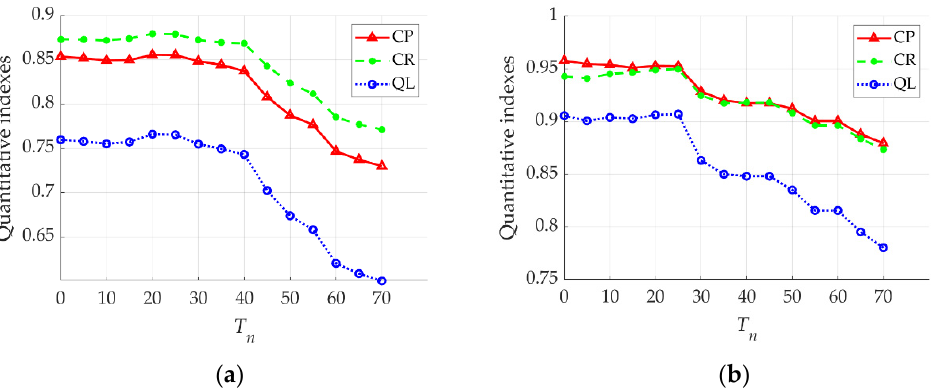
T in the experiments. ( a ) n